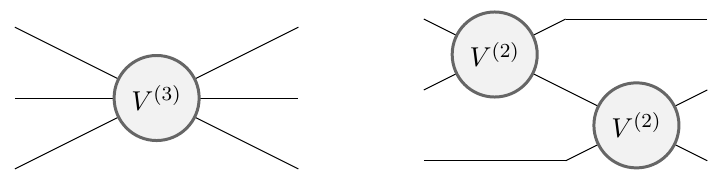
Figure 1 . (Left) contact contribution and (right) tree-like iteration contribution of 2-body inter- actions to the 3-body